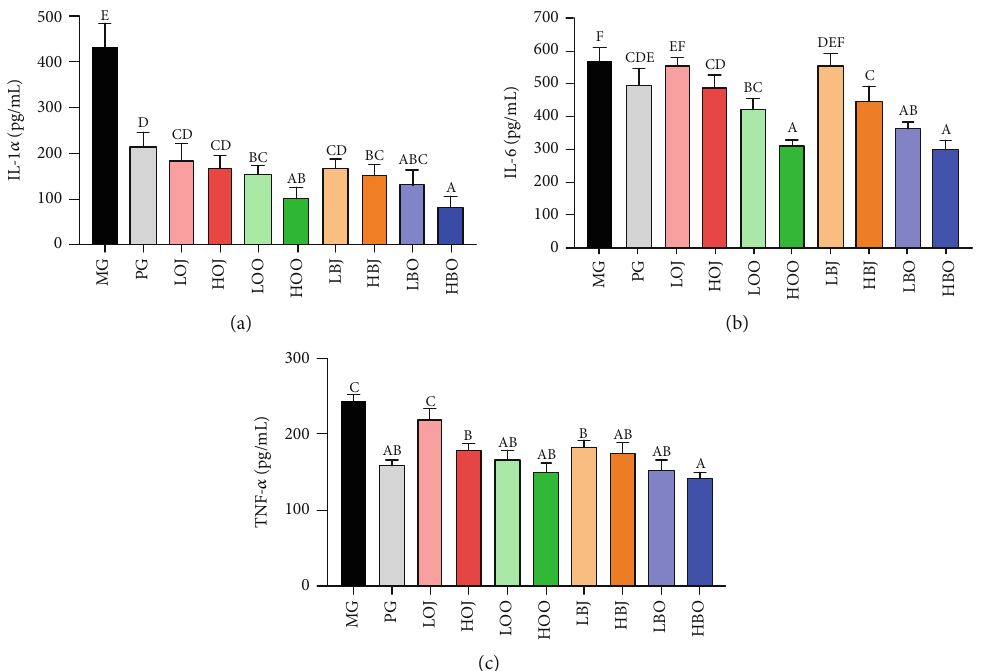
Figure 4: E ff ect of di ff erent treatments on the level of serum in fl ammatory factors in the golden hamster: (a) IL-1 α level, (b) IL-6 level, and (c) TNF- α level. Values are expressed as the mean ± SD ( n = 8 ). Data with di ff erent letters indicate signi fi cant di ff erences ( P < 0 : 05 ).